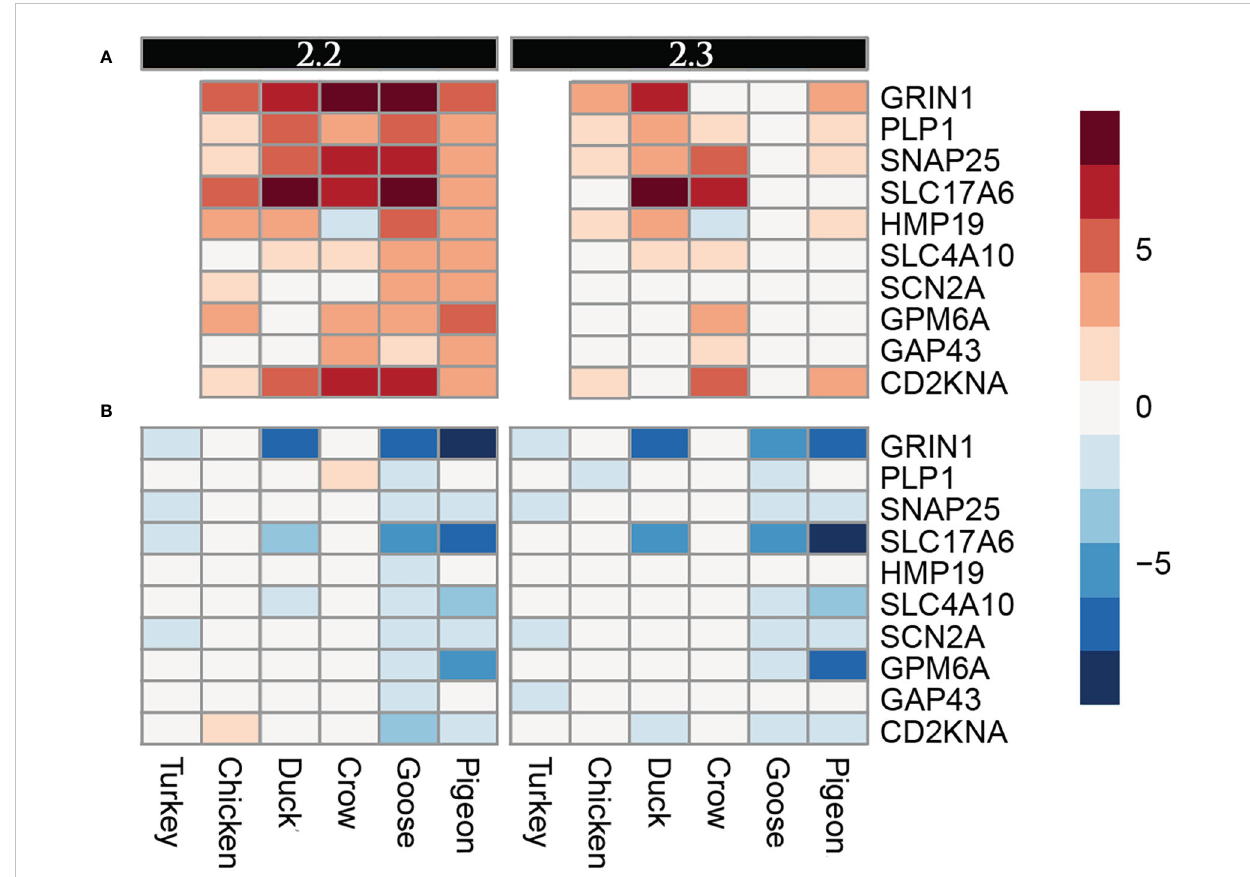
FIGURE 5 Heat map diagram of differential expression of selected nervous function genes at 12h in (A) . Lung and (B) . Ileum. Legend is logFC relative to control